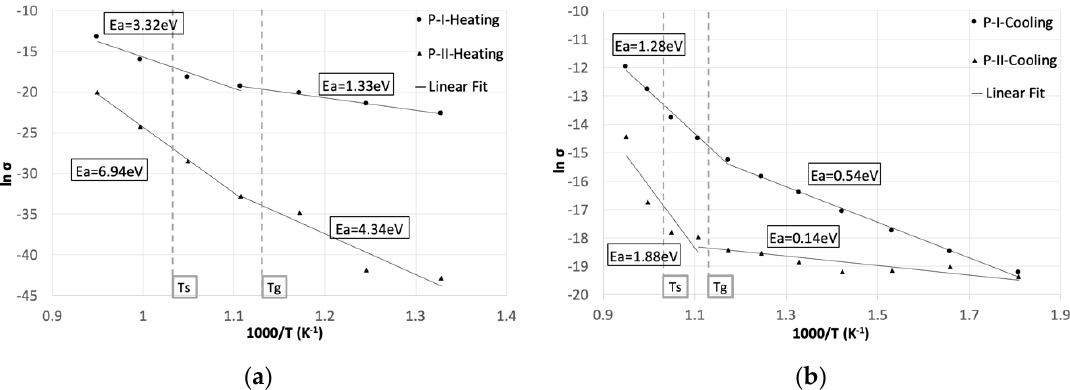
Figure 8. Temperature dependence of the specific conductivities for the high (P-I)- and low (P-II)-frequency processes ( a ) during heating and ( b ) cooling after aging for 250 h at 780 °C. Labels report the activation energies of the corresponding segments. Dashed lines indicate the softening temperature (Ts) and the glass transition temperature (Tg).